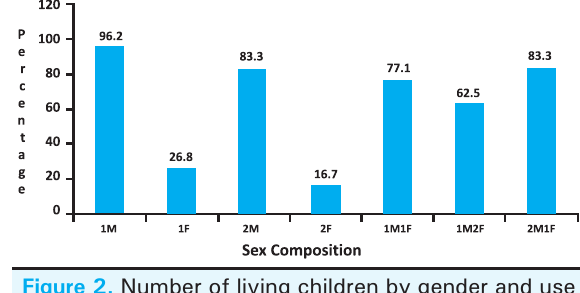
Figure 2. Number of living children by gender and use of family planning methods (N=305) Among illiterate women, the mean desire for male children was 1.44, which was signi fi cantly higher than the mean desire for female children, with 1.06. A comparable trend was observed in women with primary education where the mean desire for a male child was 1.13, which was signi fi cantly higher than that for a female child with 1.05 (Table 3).